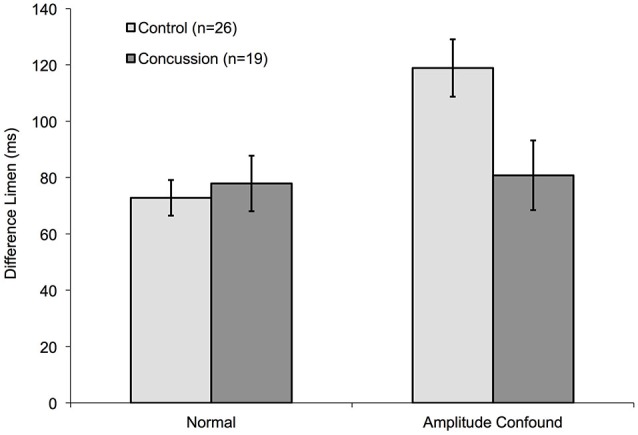
Comparison of amplitude confound impact on concussed and non-concussed individuals. The measured DLs for the duration discrimination protocol of control subjects from Figure 5 are compared to pilot data obtained from nineteen concussed subjects. Only the 400 μm Amplitude confound was used for this pilot study.